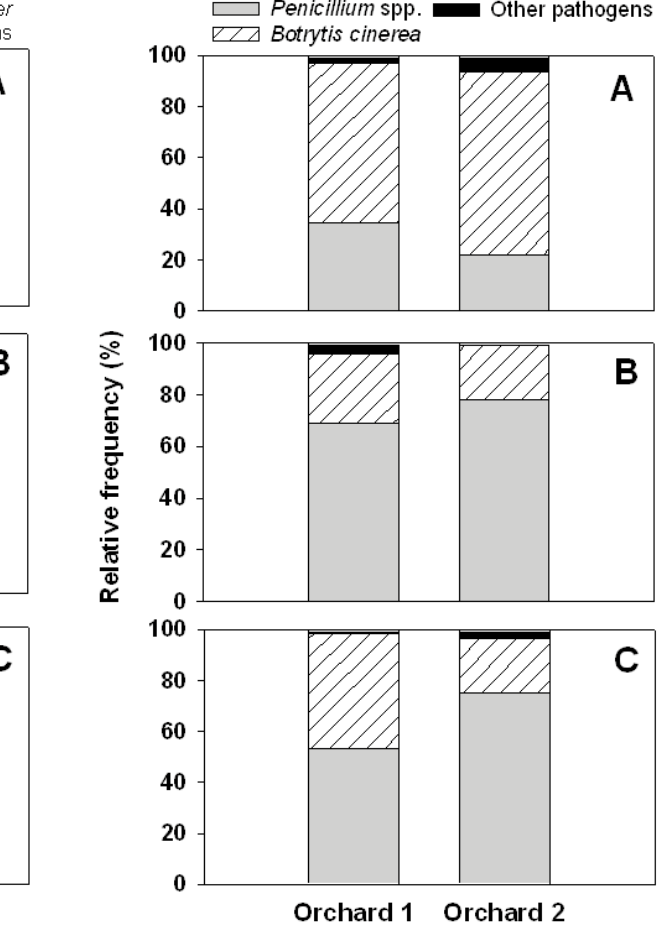
Figure 2. Relative frequency of pathogens causing posthar - vest diseases on pomegranates cv. Mollar de Elche from two orchards. The fruit were surface-disinfected (A) or arti - ficially wounded (B) and incubated at 20ºC for 7 weeks, or stored at 5ºC for 27 weeks (C). Data from the 2005 season.